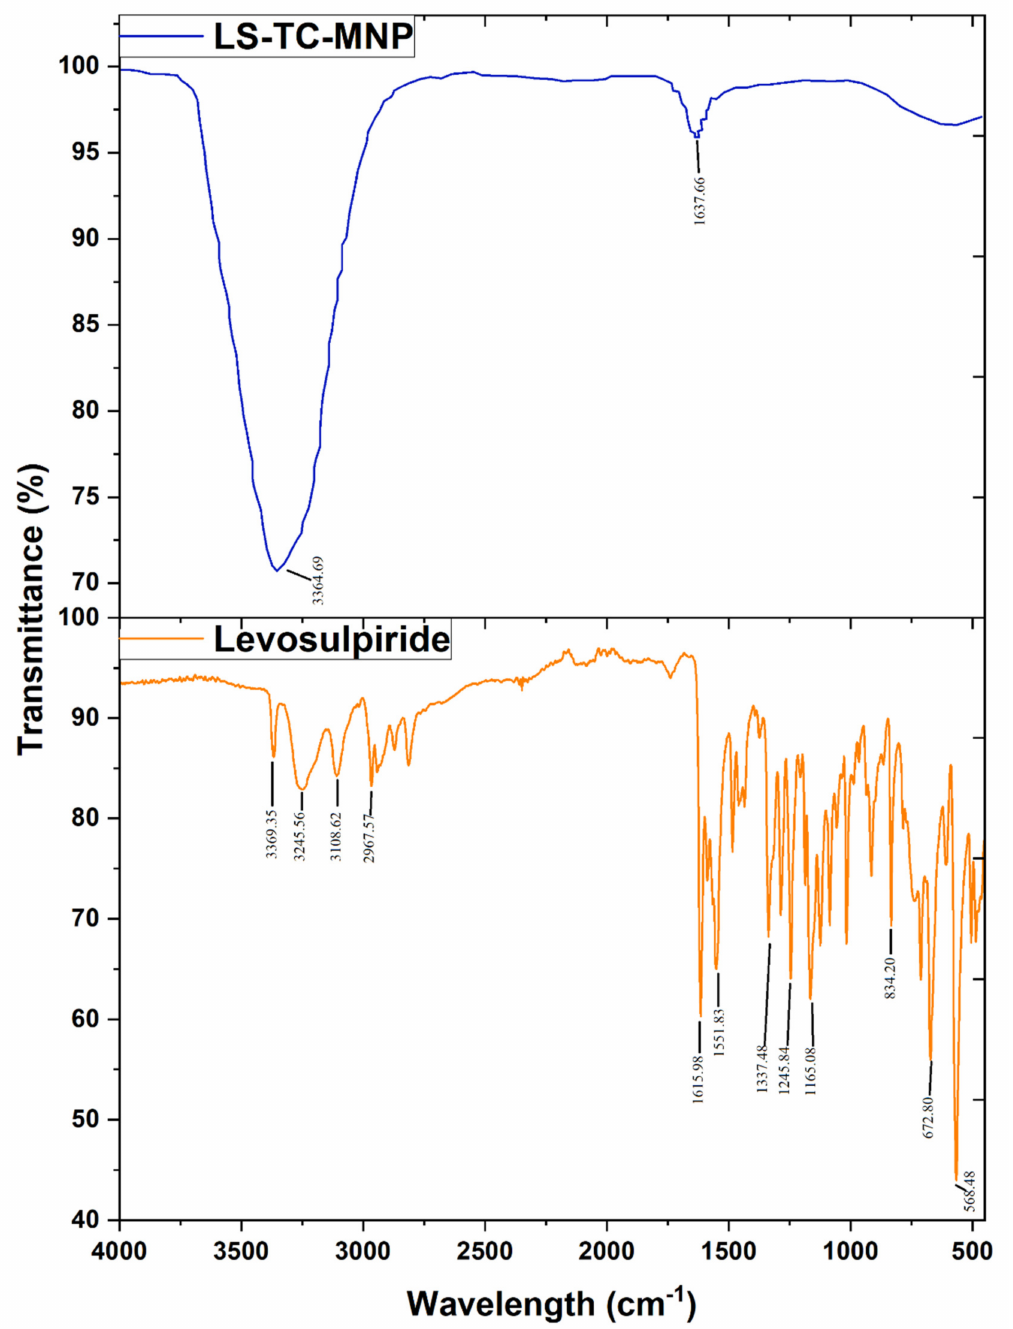
Figure 7. Fourier-transform infrared-attenuated total reflectance (ATR-FTIR) spectra of levosulpiride and levosulpiride-loaded thiolated chitosan microneedle